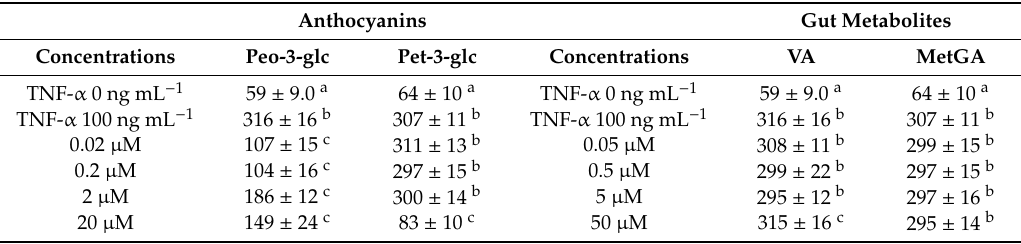
Table 3. E ff ect of peonidin-3-glucoside, petunidin-3-glucoside, vanillic acid and methyl-gallic acid on the levels of